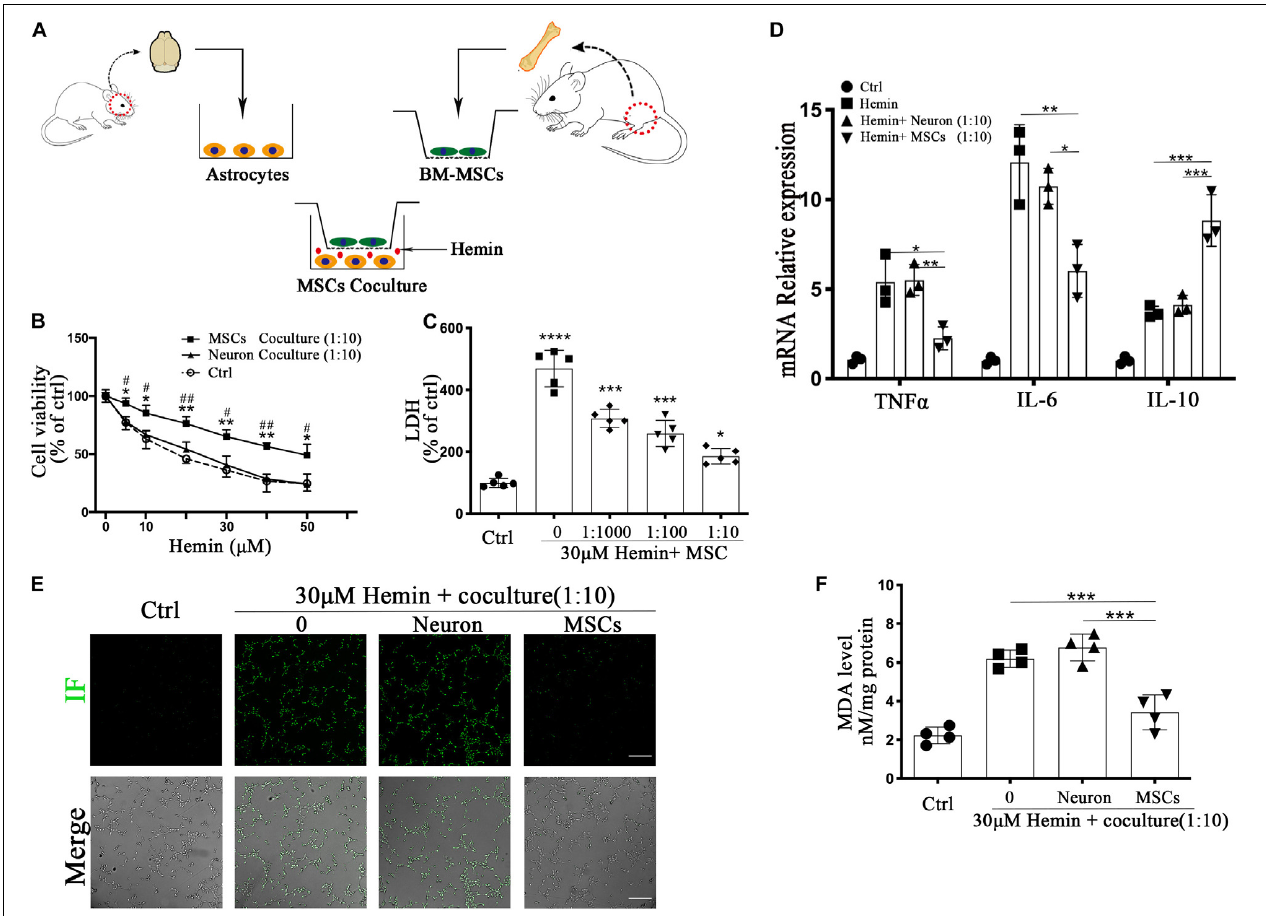
FIGURE 3 | BM-MSCs coculture protected astrocytes from neurotoxicity induced by hemin. (A) Schema of primary cells and co-culture of rat BM-MSCs and mouse astrocytes. (B) Astrocytes were exposed to 0, 5, 10, 20, 30, 40, 50 µ M hemin for 24 h with or without BM-MSCs/Neuron coculture, then the cell viability was evaluated by CCK-8 ( n = 5). (C) Astrocytes were exposed to 30 µ M hemin with or without BM-MSCs for 24 h, and the cell death was evaluated by LDH releasing assay ( n = 5). (D) mRNA expression of TNF α , IL-6, and IL-10 was checked, and the relative expression of the mRNA was normalized to control ( n = 3). (E) After DCFH-DA probes were loaded, the intracellular ROS was observed using fluorescent microscopy, bar = 400 µ m. (F) The contents of MDA in the astrocytes were determined ( n = 4). All data are displayed as means ± SD. The difference between groups was analyzed using One-way ANOVA test. * p < 0.05, ** p < 0.01, *** p < 0.001, **** p < 0.0001, compared with control (0 µ M); # p < 0.05, ## p < 0.01, compared with Neuron coculture